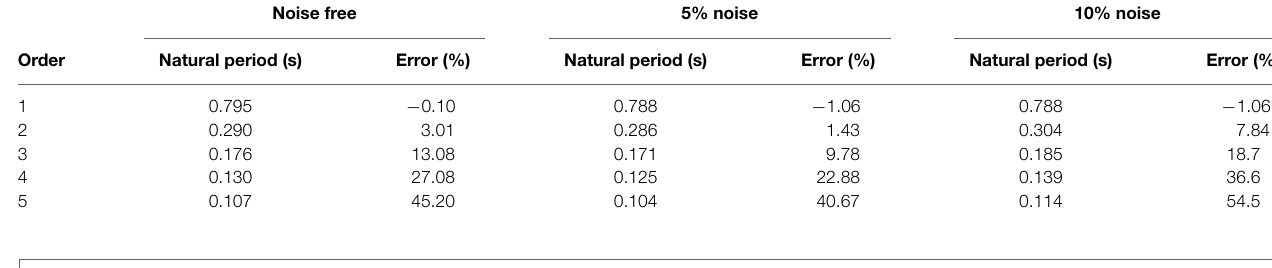
TABLE 5 | Error ratio of identified natural periods in non-simultaneous measurement with/without noise.